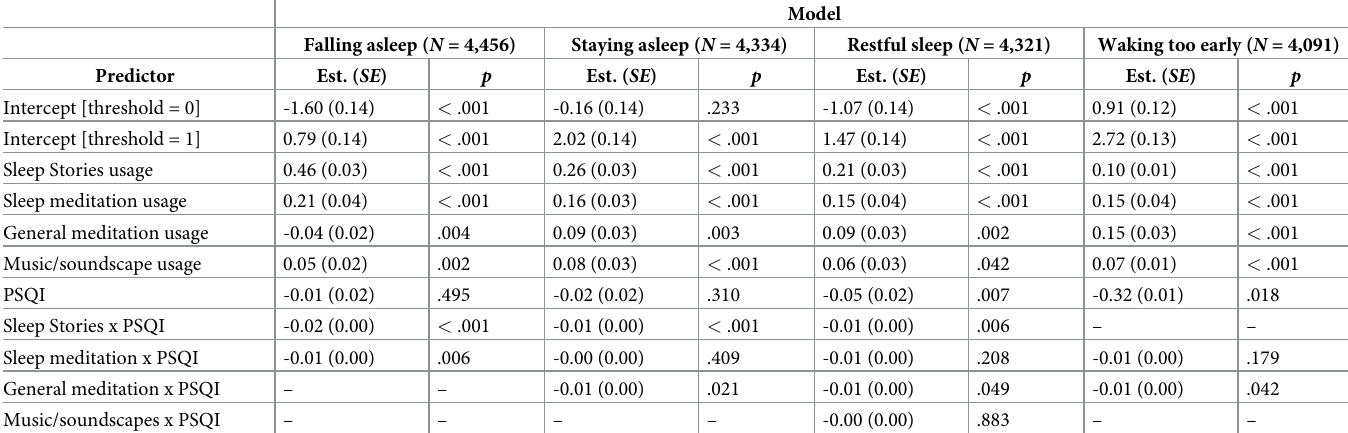
Table 7. Parameter estimates for regressions models of improvements in sleep difficulties based on PSQI scores and frequency of using all Calm components.